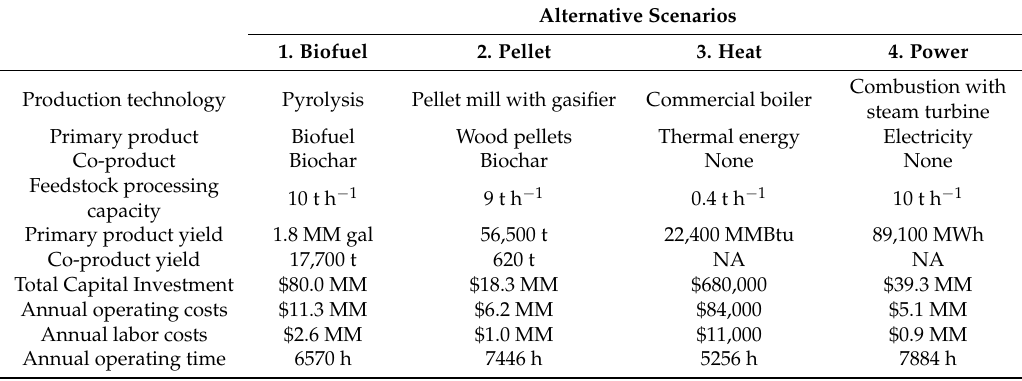
Table 1. Description of scenarios. MM: